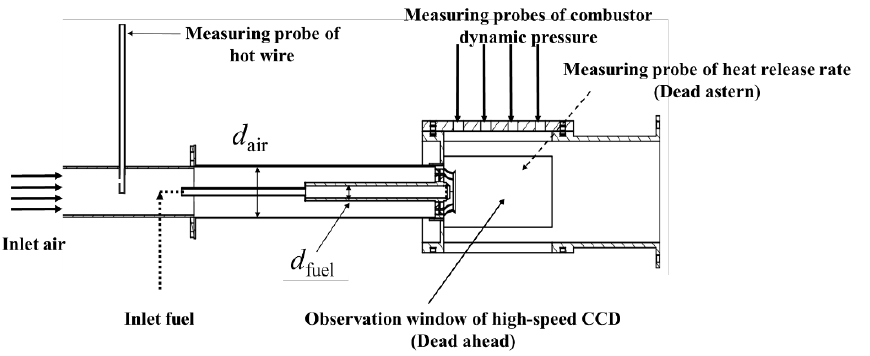
Figure 2. Schematic diagram of model combustor experimental setup.